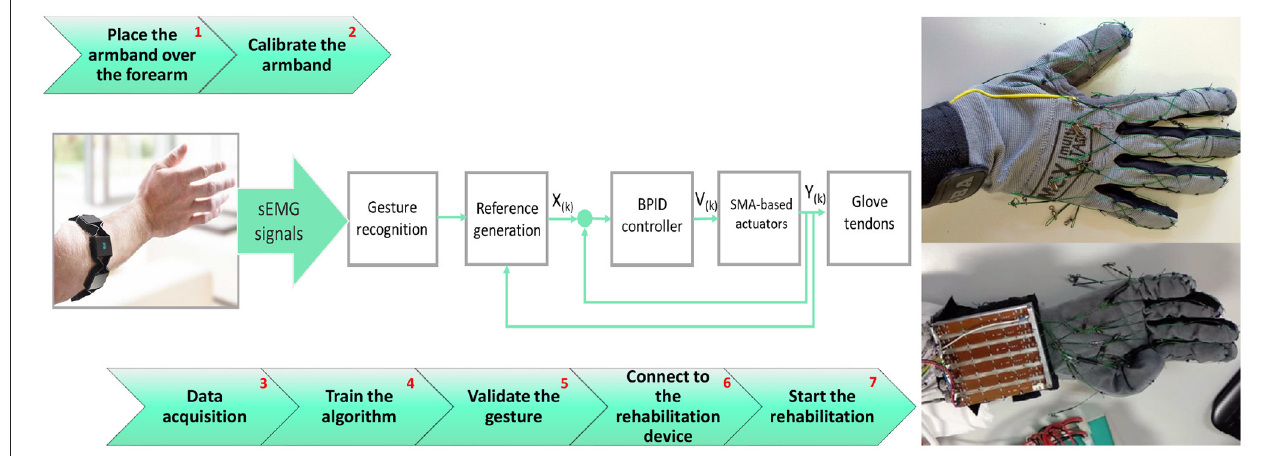
FIGURE 3 | Overview of the proposed rehabilitation